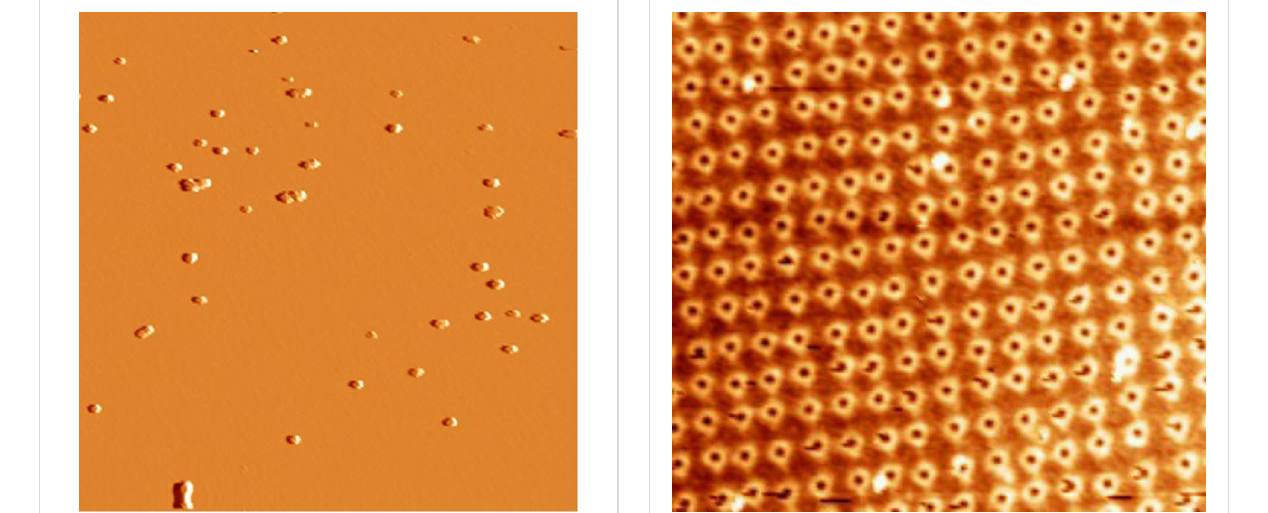
cating role of the adsorbed water layer between the particle and the substrate in both the free (Brownian) and externally-driven motion of nanoparticles.